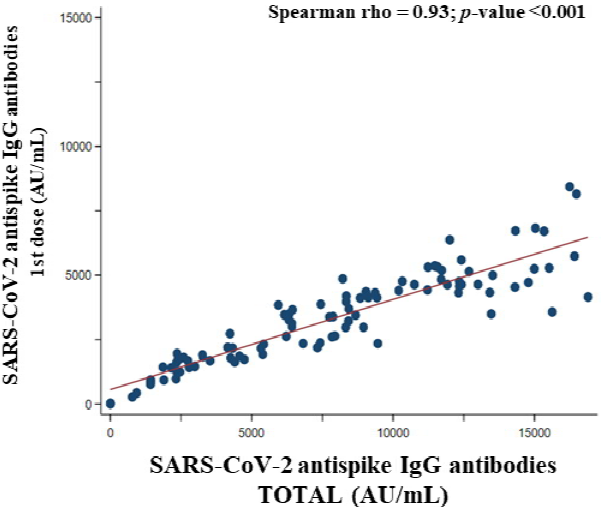
Figure 9. Correlation between SARS-CoV-2 anti-spike IgG antibody titer (AU/mL) after the first dose of BNT162b2 vaccine and total SARS-CoV-2 anti-spike IgG antibody titer.